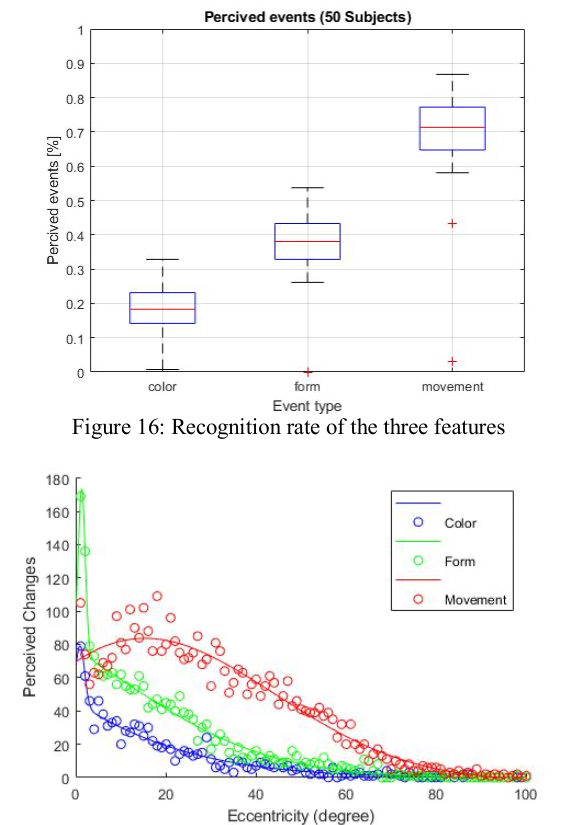
Figure 17: Perceived changes of the three features as Gauss- ian graphs, fitted to the perceived object changes eccentricity